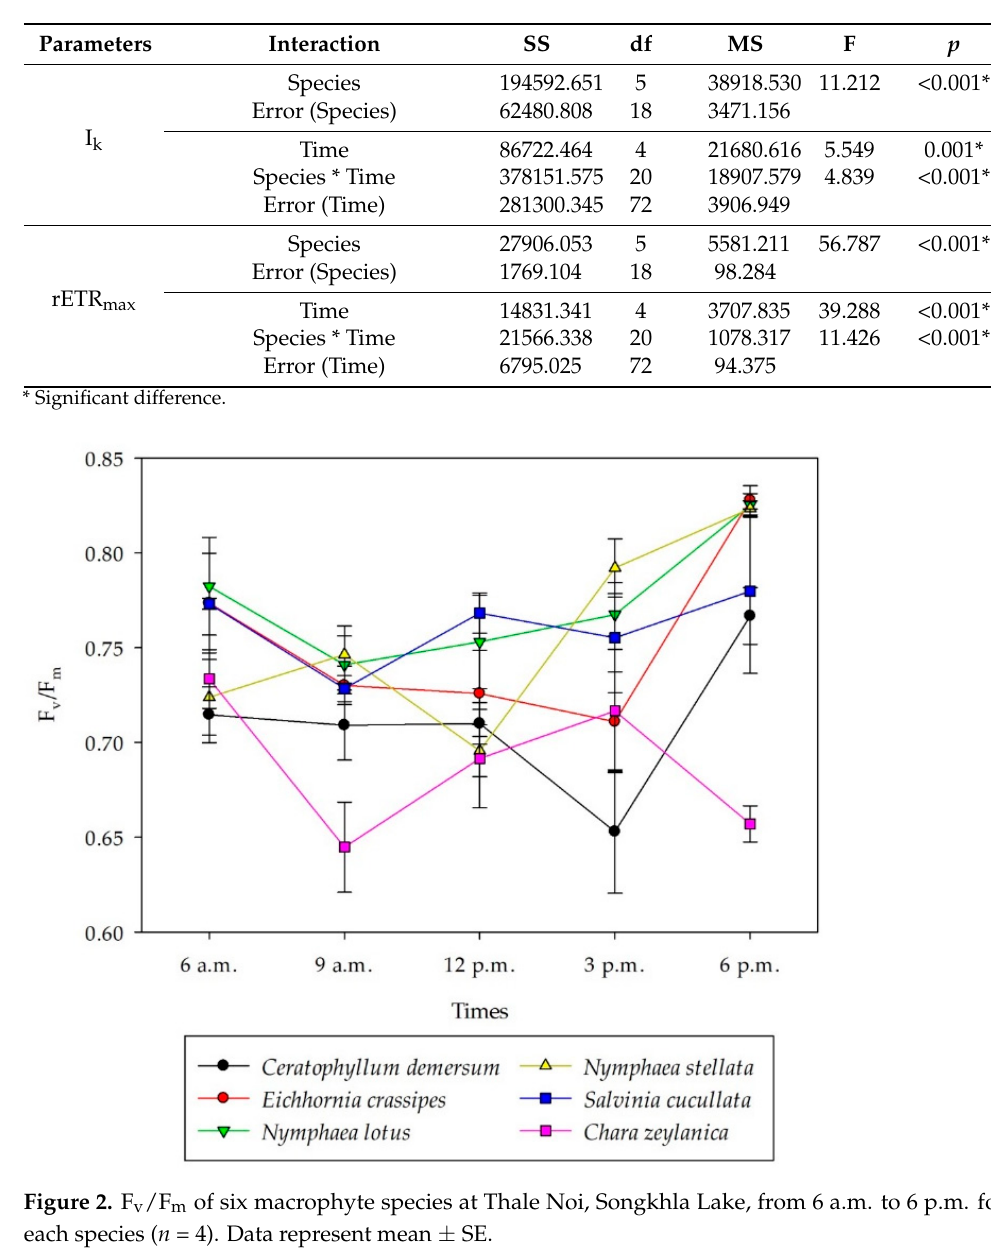
Figure 1. Air and water temperatures ( a ) and light intensity of air and water ( b ) at Thale Noi, Songkhla Lake from 6 a.m. to 7 p.m. ( n = 3). Data represent mean ± SE.